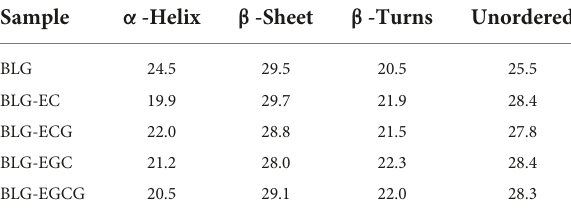
TABLE 3 Secondary structure contents of BLG-catechin